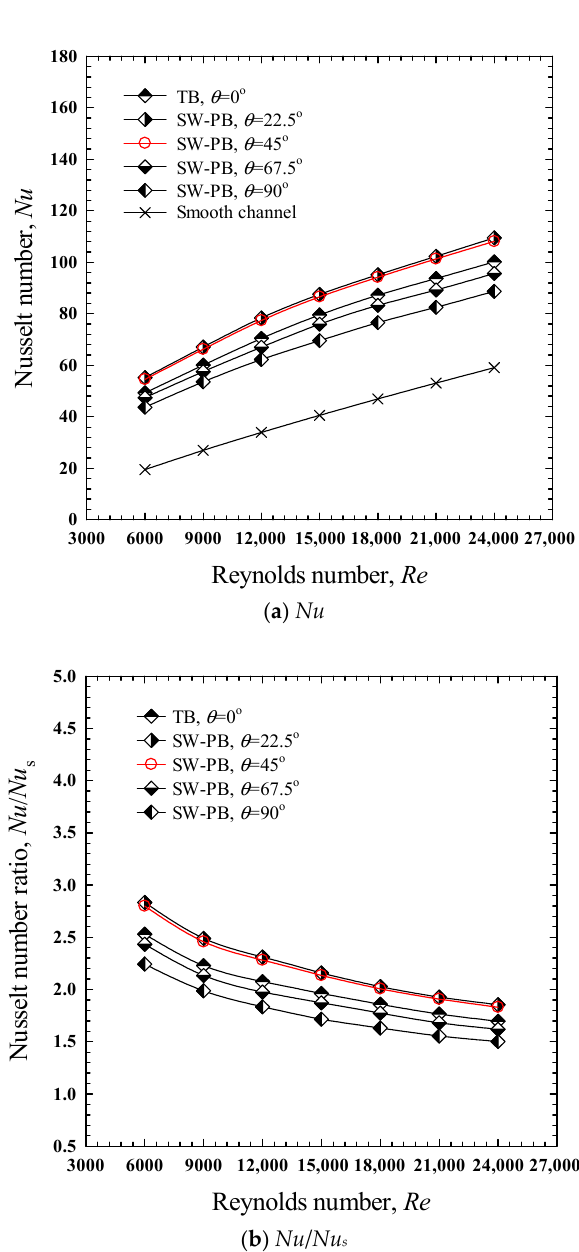
Figure 6. Nusselt number ( Nu ) and Nusselt number ratio ( Nu / Nu s ) of a channel with square-winged transverse baffles (SW-TBs).